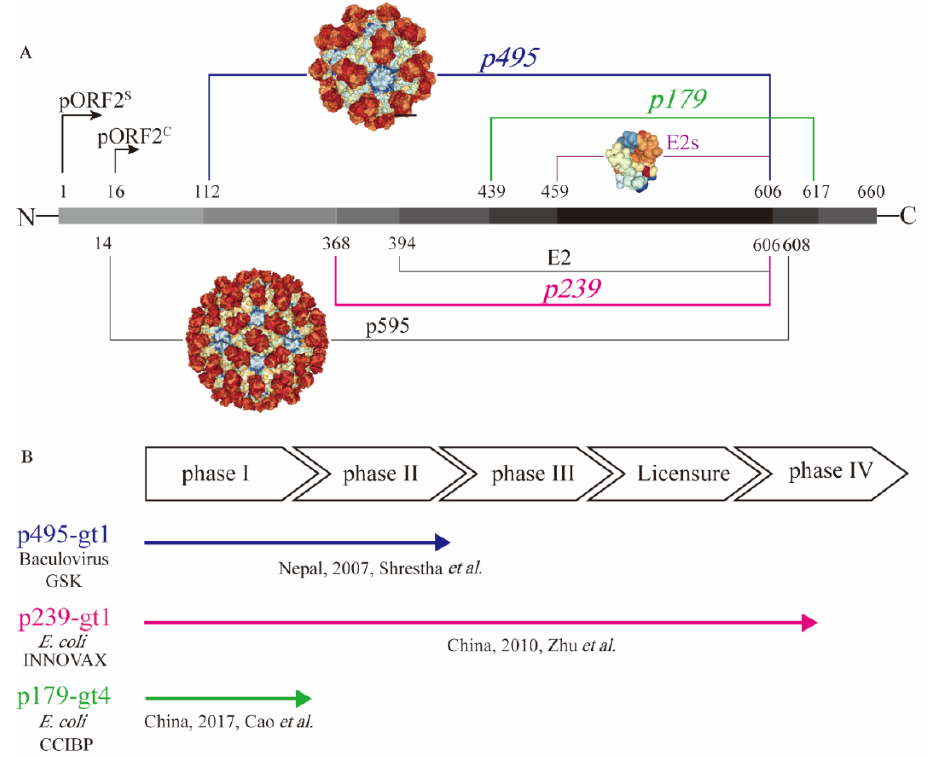
ff erent truncated versions of hepatitis E virus (HEV) pORF2. ( A ) Figure 1. Presentation of different truncated versions of hepatitis E virus (HEV) pORF2. ( A ) shows Figure 1. Presentation of di